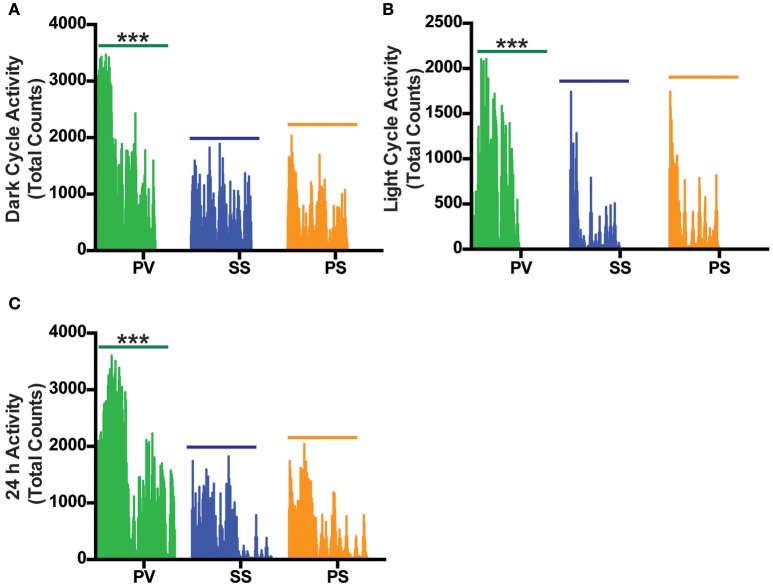
Bilateral subdiaphragmatic vagotomy increases total activity in fully obese Mc4r−/− mice. (A,B) Vertical bar plot of total activity (combination of axial and fine movements) during the dark and light cycle acquired over an 18–28 h period that was sampled at 10-min intervals; n = 5–8 per treatment group. (C) Vertical bar plot of 24 h LA activity. ***p < 0.001 criterion for statistical significance.